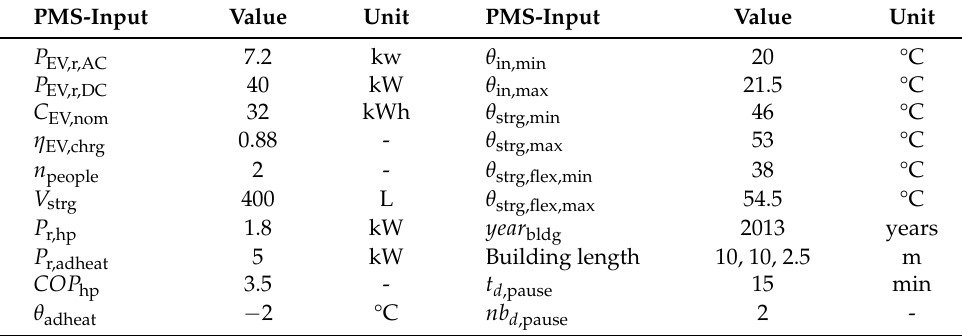
Table 5. Unique end-user inputs for PMS extension